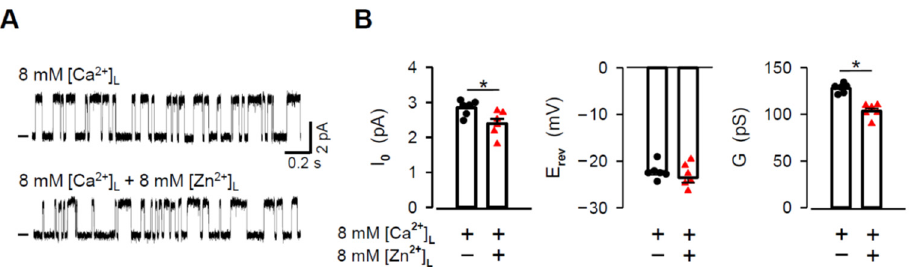
Figure 5. Luminal Zn 2+ decreases the RYR2 current under near-saturating conditions. ( A ) Represen- tative RYR2 currents, shown as upward deflections from the marked zero-current level, for 8 mM [Ca 2+ ] L (control, top trace) and when 8 mM [Zn 2+ ] L was added (bottom trace). RYR2 channels were activated by 1–2 mM caffeine in the presence of 90 nM free [Ca 2+ ] C . Current recordings were conducted at 0 mV and are from the same channel. ( B ) The I 0 , E rev and G values obtained in the absence and after luminal Zn 2+ exposure. * Significantly different from the control values when only luminal Ca 2+ was present (paired Student’s t test). Data shown are average ± SEM of 6 experiments. Data points shown in ( B ) are individual measurements (Ca 2+ –black circle and Zn 2+ /Ca 2+ –red trian- gle).